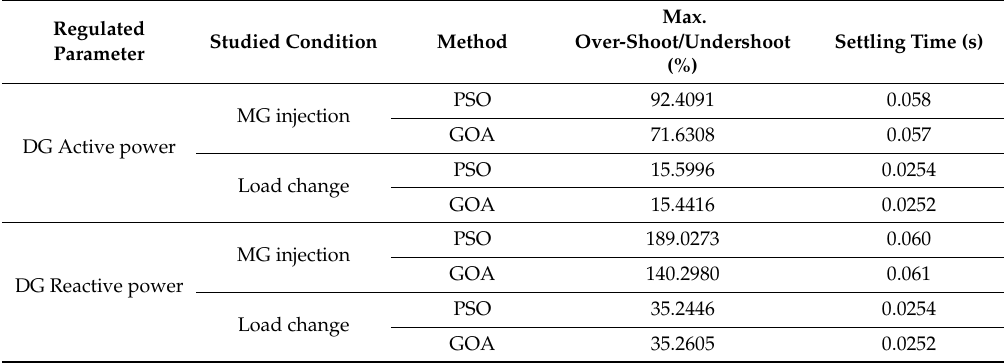
Table 3. Dynamic response comparison between PSO- and GOA-based